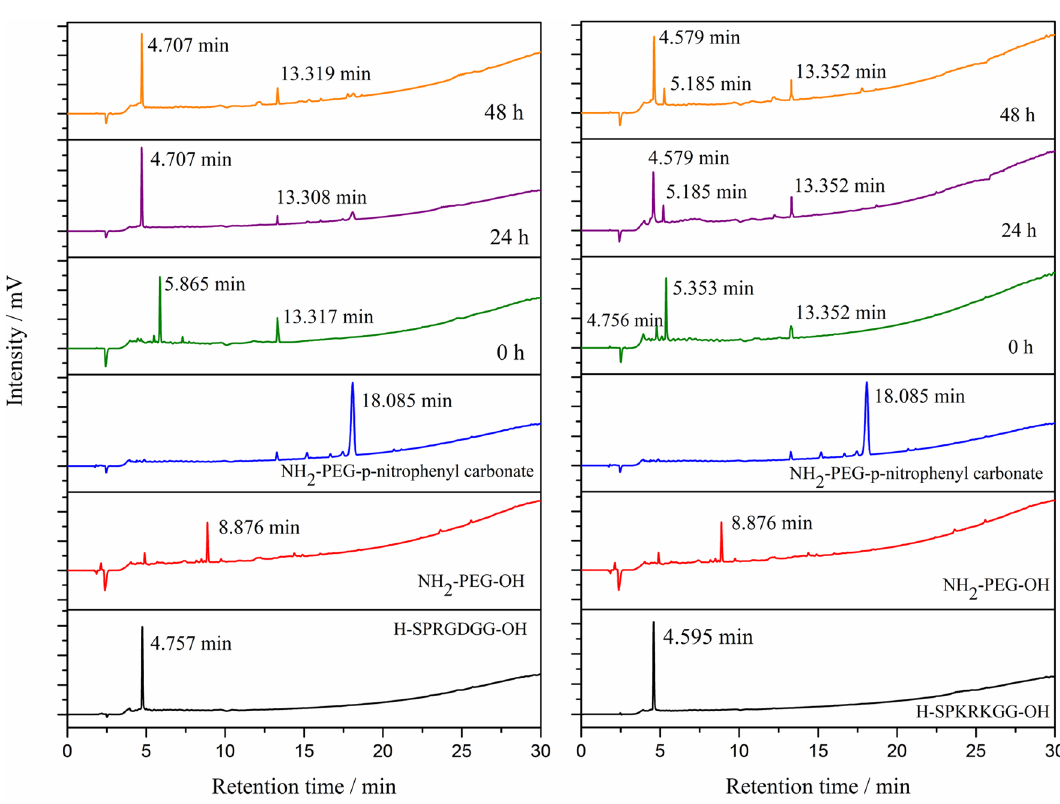
Figure 5. Covalent bioconjugation of PEG linker with RGD and KRK peptides’ reaction progress monitored by Reversed Phase High Performance Liquid Chromatography. RP-HPLC conditions: HPLC Shimadzu system (Shimadzu Prominence-i LC-2030C) with Cosmosil C18 column (4.60 mm × 250 mm, 90 Å, 5 µm) using linear gradient method from 0 to 100% solvent B for 30 min at a flow rate of 1.50 mL min −1 with UV detection at λ 1 = 224 nm and λ 2 = 254